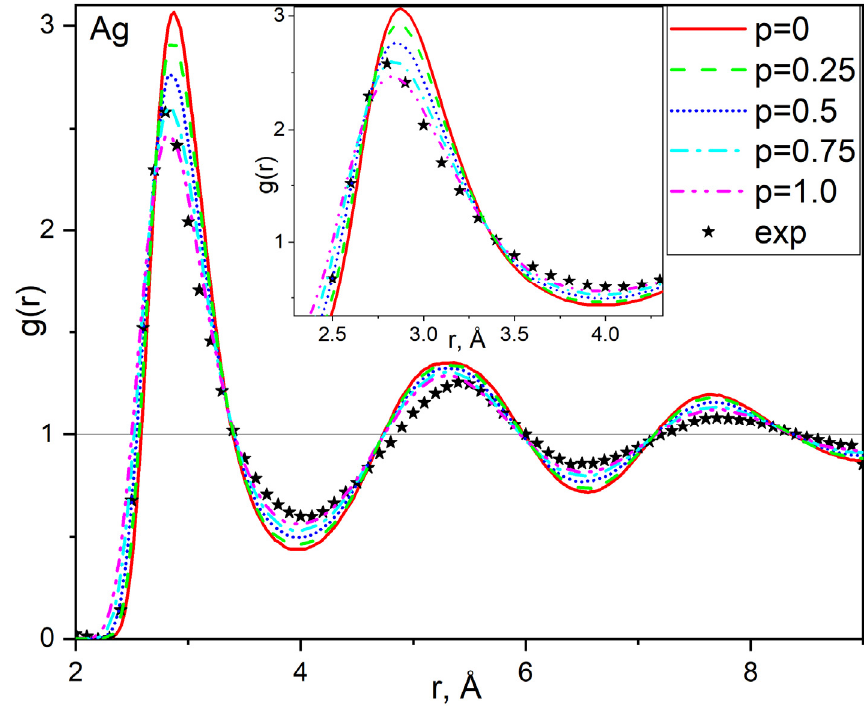
Figure 6. Pair correlation functions of liquid Ag at T = 1273 K and different p in comparison with experiment [38].